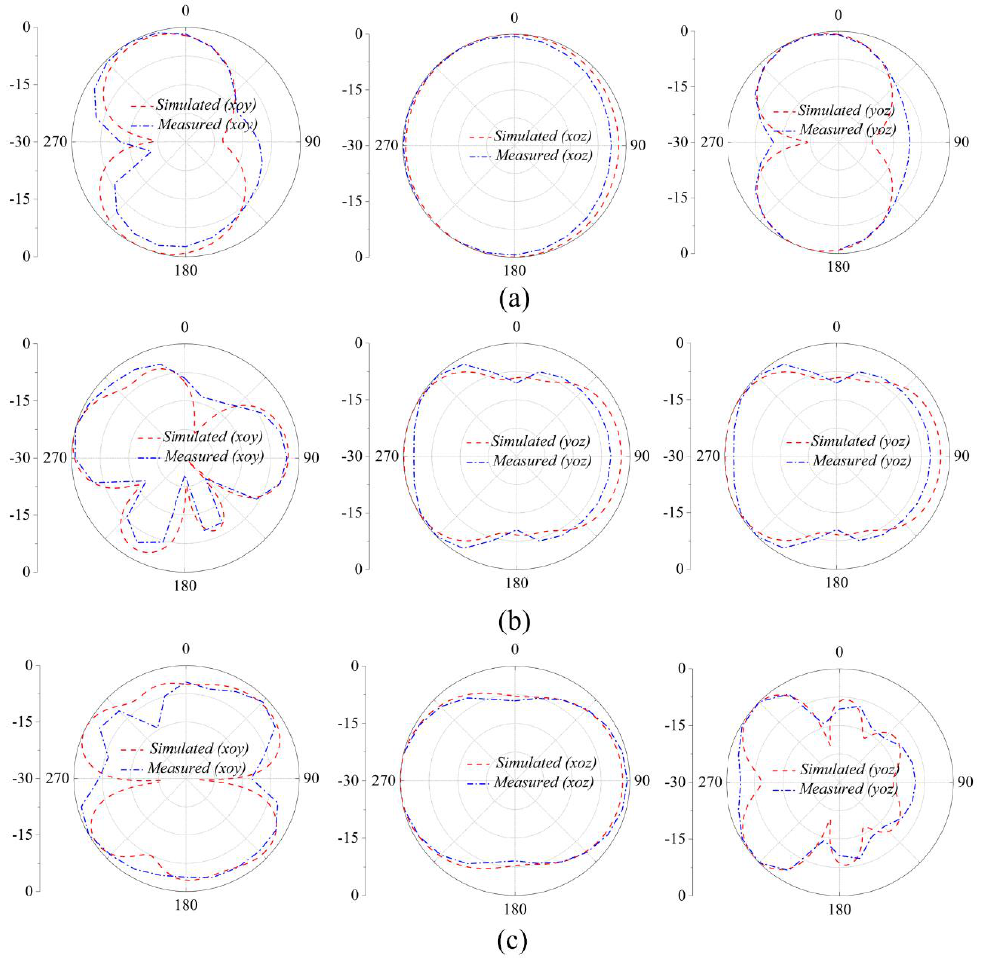
Figure 13. Simulated and measured radiation patterns of the proposed antenna: ( a ) at 0.840 GHz; ( b ) at 1.900 GHz; ( c ) at 2.500 GHz.